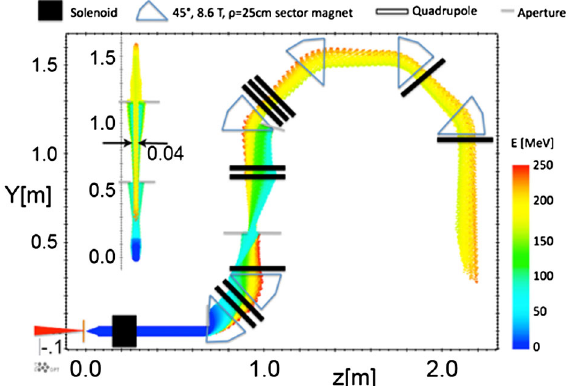
FIG. 14. Simulation results from feasibility study: Proton tracking of the scaled TNSA spectrum of Fig. 3 through a pulse power solenoid coupled to a theoretical achromatic pulse power gantry. The large image shows the z ½ m (cid:6) , y ½ m (cid:6) profile while the inset in the top left shows the x ½ m (cid:6) , y ½ m (cid:6) profile. The quadrupole gradients are up to 400 T = m over 5 cm or less, and the dipole fields are 8.6 T.